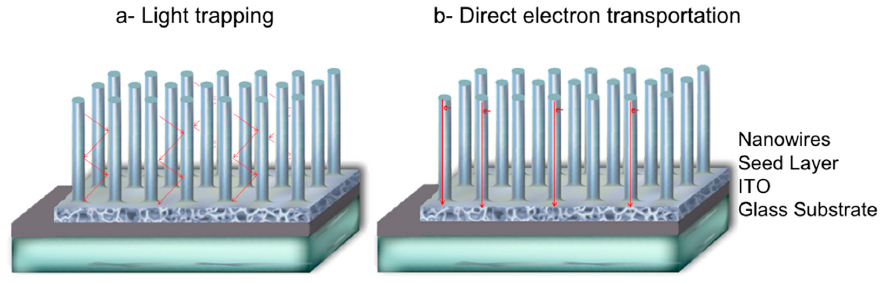
Figure1. Illustrationof( a )lighttrappinginnanowiresarraysand( b )electrontransportinverticalnanowires. Figure 1. Illustration of ( a ) light trapping in nanowires arrays and ( b ) electron transport in vertical nanowires.